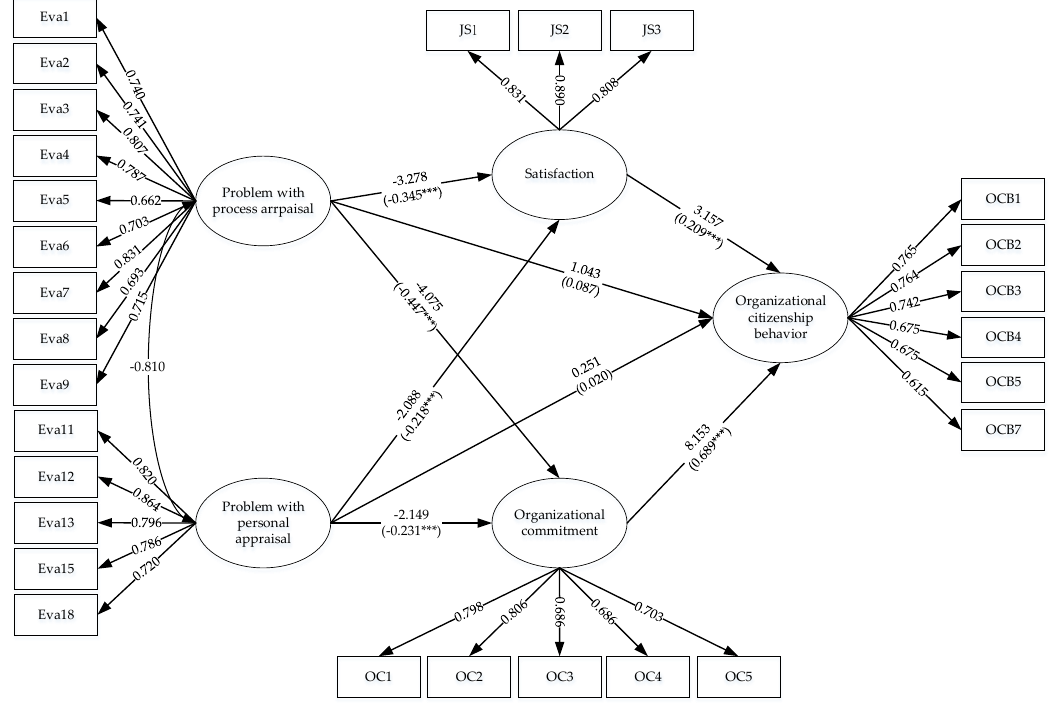
Figure 2. Adjusted structural equation according to program suggestions and analysis of 5000 rounds of bootstrapping. *** means significant level at 0.001.